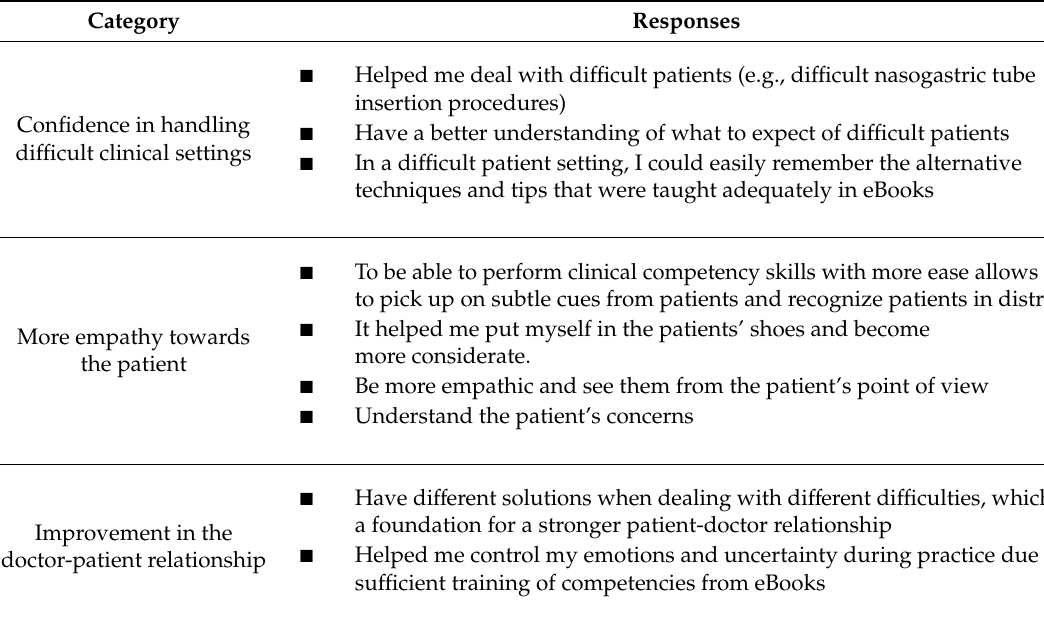
Table 5. Students’ open-ended responses from eBook